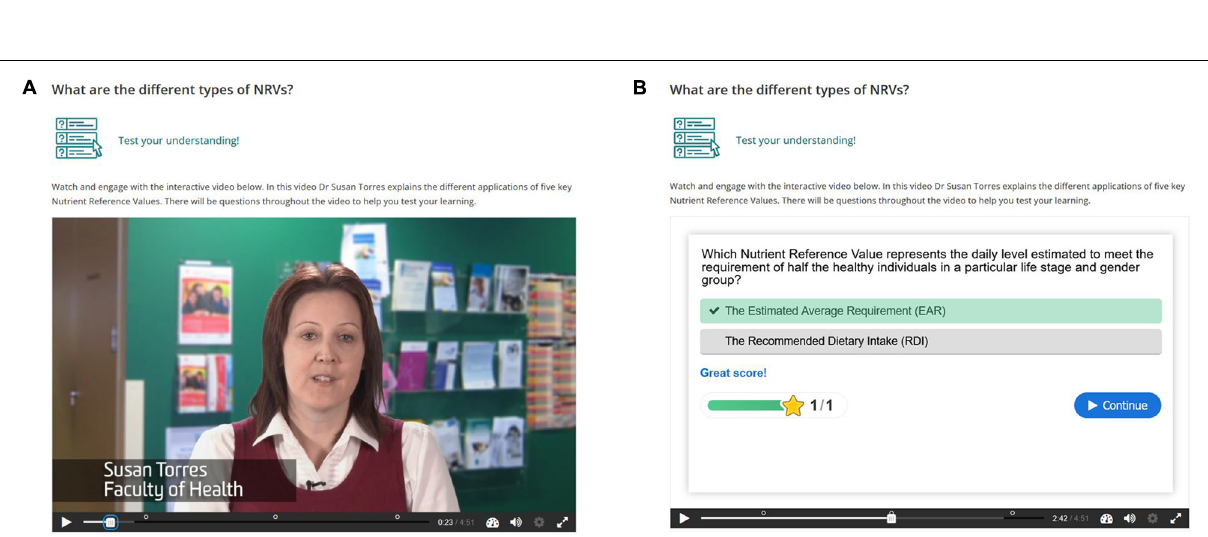
FIGURE 2 | Example of an online interactive video (A) with an activity imbedded within the video for the student to complete (B) Screenshots © Deakin University. All Rights reserved. Reproduced with permission by Deakin